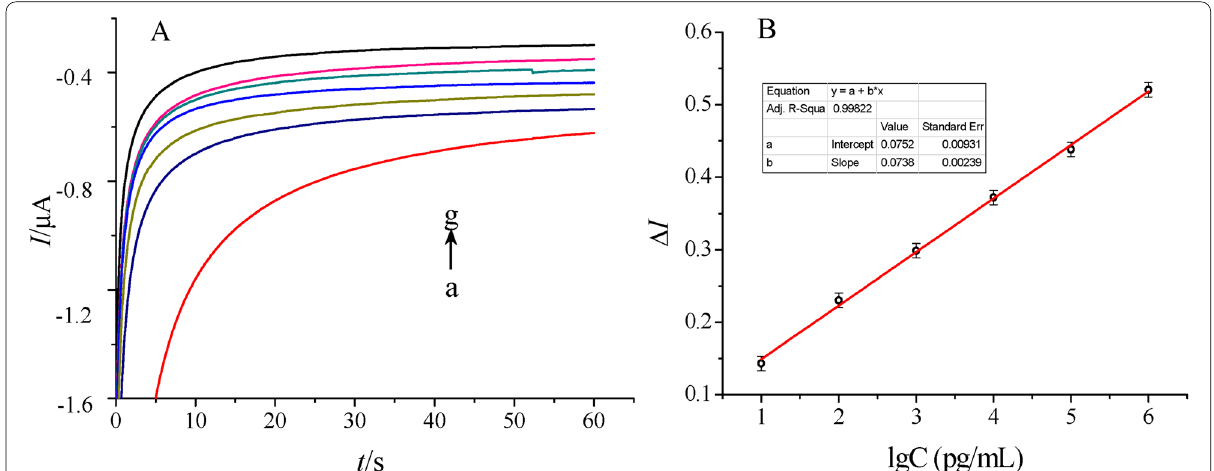
Fig. 2 A Current response curves obtained for the determination of THC: a 0.01 M PBS (phosphate buffer saline) solution at pH 7.4 as the blank, b~g are the signals obtained for diluted THC solutions at increasing proportions with PBS, the mass concentration has been 0.01~103 ng/mL. B Calibration curve for the determination of THC. Taken from (Dingqiang et al. 2016) under permission policy of Molecules (Copyright